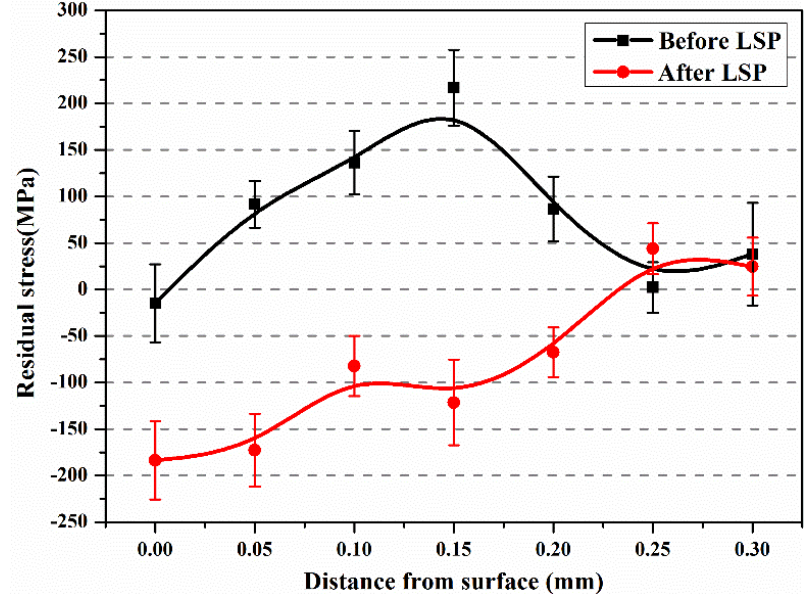
Figure 6. Residual stress of SLM-fabricated Ti64 samples before and after LSP. Materials 2020 , 13 , x FOR PEER REVIEW